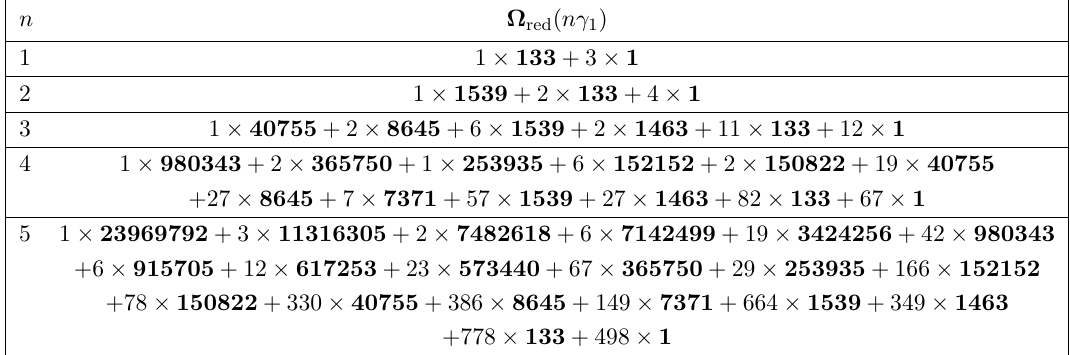
Table 3 . Reduced indices for charges n ( (cid:13) 1 + (cid:13) 2 ) in the E 7 Minahan-Nemeschansky theory, with (cid:13)avor information